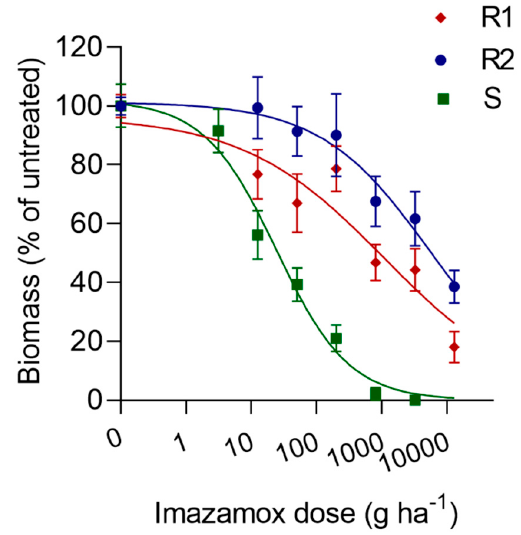
Figure 1. Dose-response curves for two imazamox-resistant wild poinsettia ( Euphorbia heterophylla ) populations. R1 is also resistant to PPO-inhibiting herbicides and R2 is also resistant to glyphosate. Model fit: y = a / [1 + (x / c) b ]. Error bars represent the standard error of the means ( n = 8).